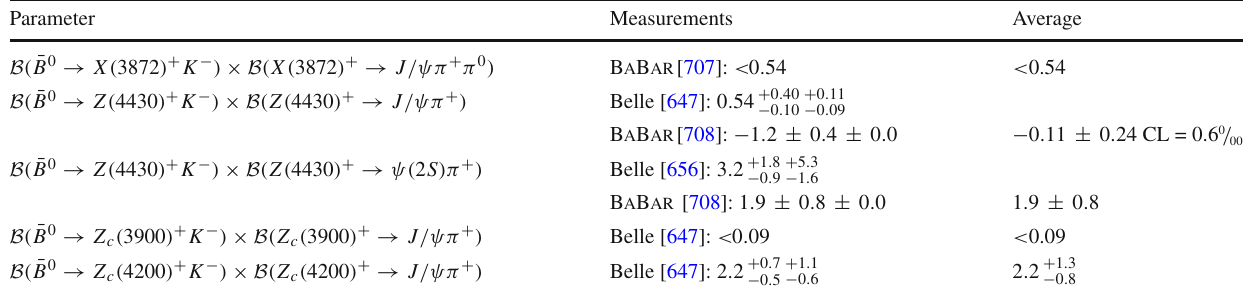
Table 133 Decays to charged states II [ 10 − 5 ]